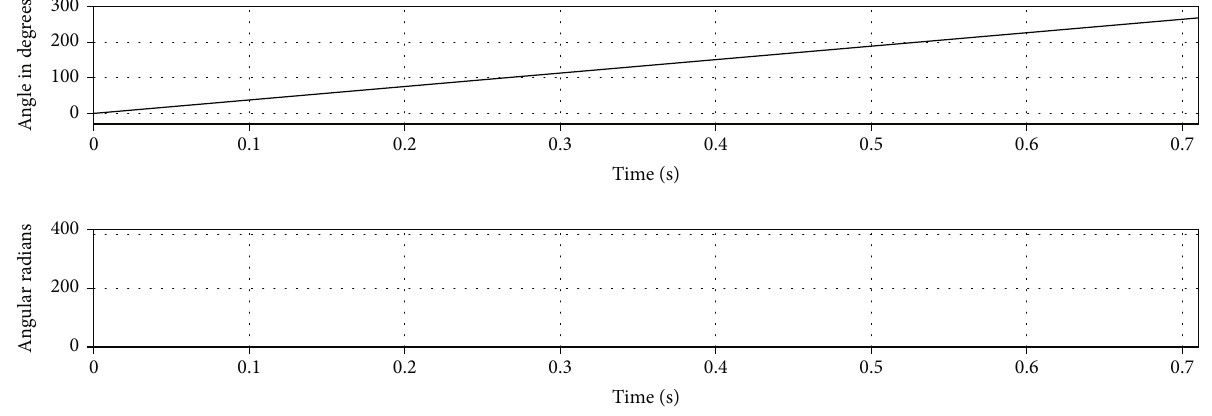
Figure 15: Angular radians and radians/sec for DER2.